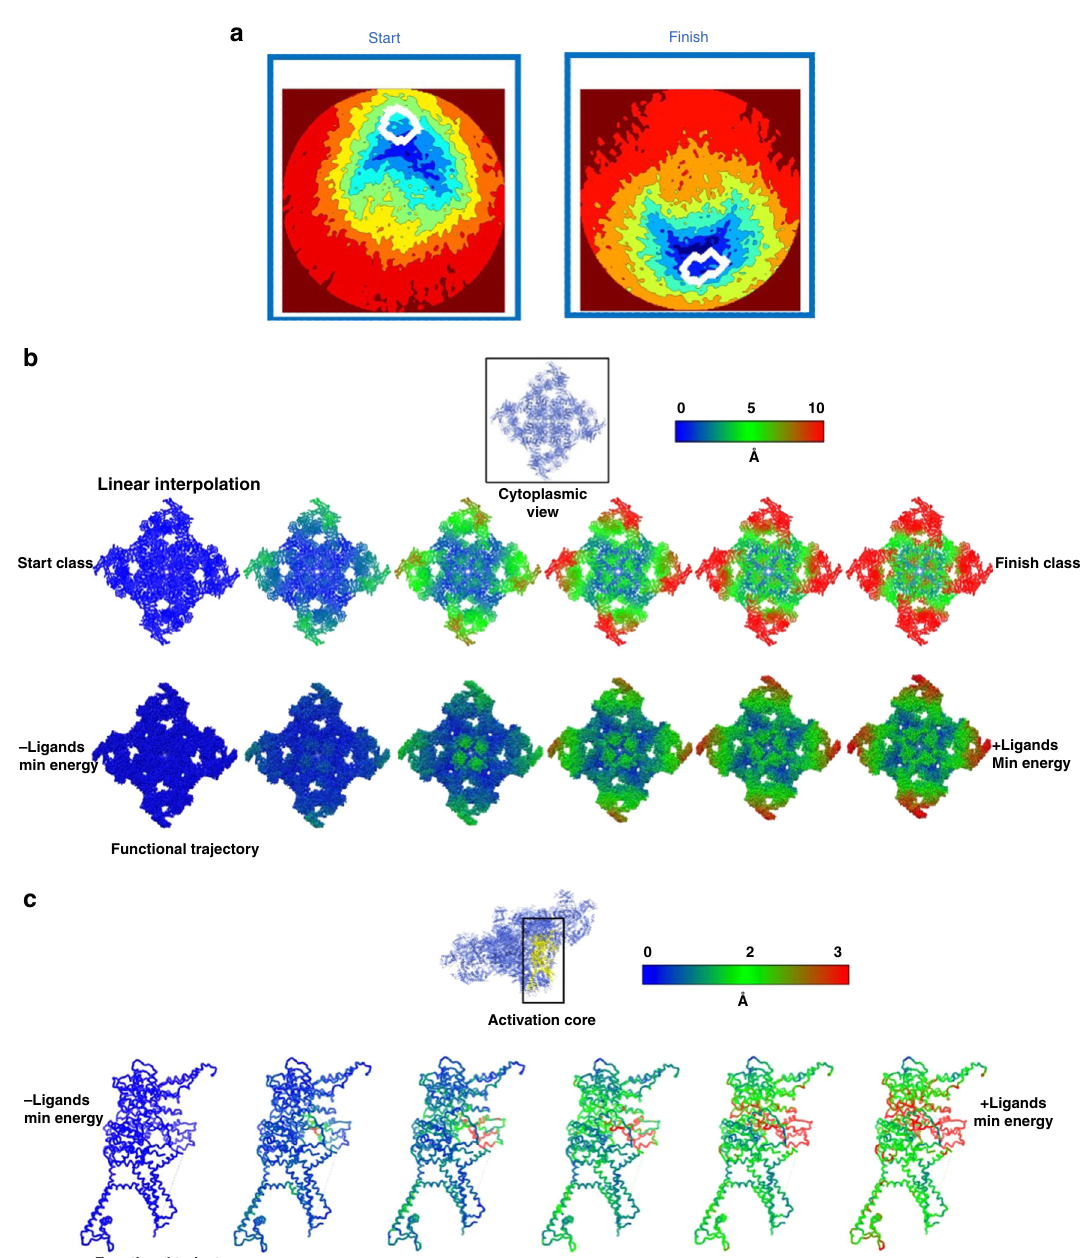
Fig. 6 Functional path vs. interpolation between discrete clusters. a Distribution on the energy landscape of Fig. 1a of snapshots assigned by maximum likelihood to two discrete conformational clusters. Each white curve encloses a region of high snapshot density. These two classes were previously identi fi ed as representing the extremes of the conformational range, and used to infer function by discrete cluster analysis 22 . b Overall conformational changes along the functional path vs. linear interpolation between the two maximum-likelihood classes previously used for functional inference 22 (see panel a ). The ryanodine receptor 1 (RyR1) atomic model is shown in sphere representation, with color indicating the displacement of each atom from its “ START ” position. c Conformational changes in the activation core domain (residues: 3614-5037) along the functional path of Fig. 1a. The RyR1 backbone structure is shown as sticks, with the color of each atom indicating its atomic displacement (see color bar). The largest atomic displacements along the functional trajectory are con fi ned to a narrow allosteric conduit connecting the ligand-binding sites to the EF However, the degeneracy g c induced by coarse-graining is unknown, and, in equilibrium. A conformational bin contains all conformations indistinguishable by the experimental and data-analytical pipeline used ( “ coarse-graining ” ). general, conformation-dependent. g c can be absorbed into the exponent via an The experimental observable, namely the number of sightings of a entropy term, viz. conformational state c is given by: ð 3 Þ n c ¼ N snapshots Z (cid:1) 1 g c e (cid:1) Ec KT : ð 2 Þ with the superscript cg short for coarse-graining. In principle, Eq. (2) provides a direct link between the number of sightings Equations (2) and (3) implicitly assume that all conformations coarse-grained (snapshots) of a conformation, and its energy. into the same conformational class have the same energy. This need not be the